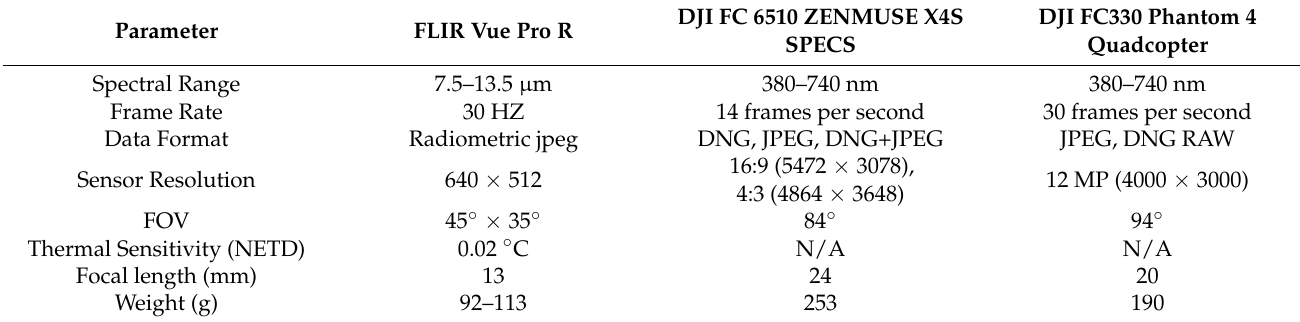
Table 1. Thermal and optical camera specifications used for the data collection.